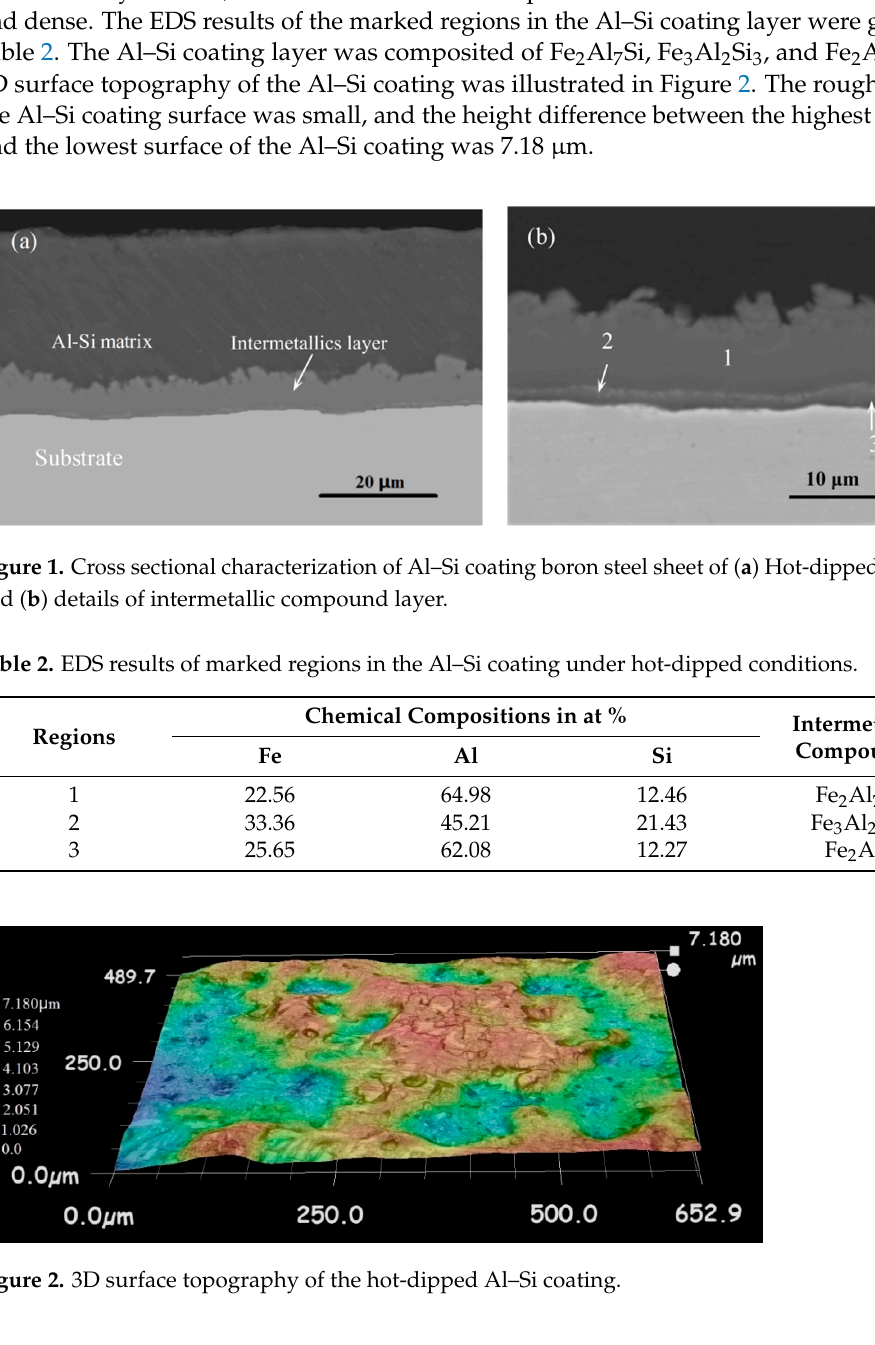
Table 1. Chemical compositions of the substrate in wt % [37].